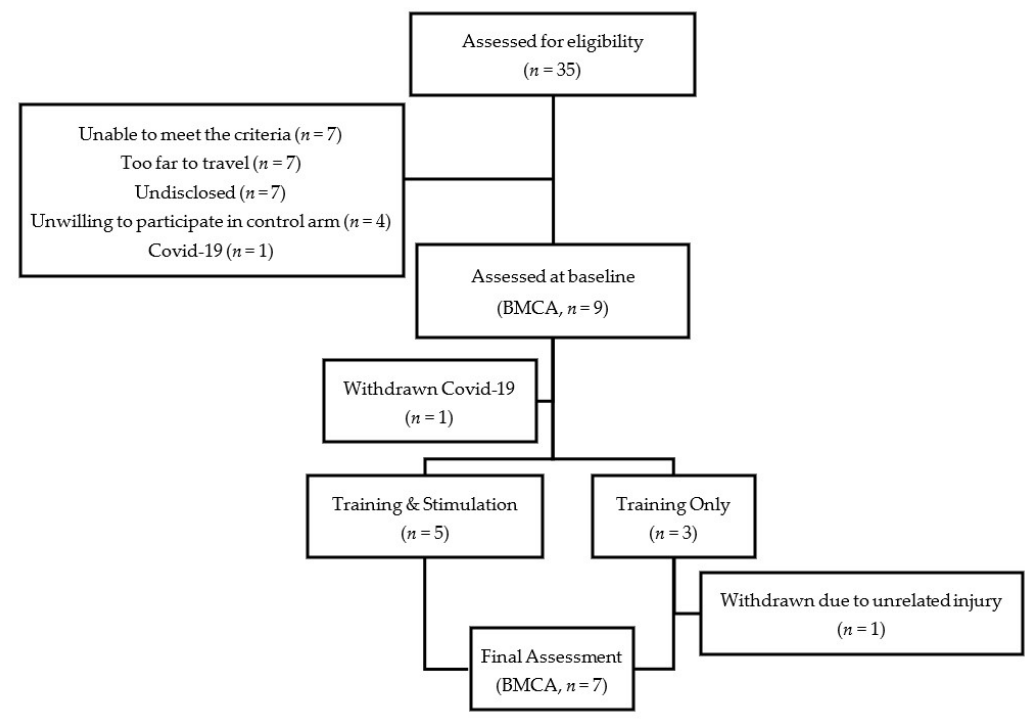
Figure 1. CONSORT flow diagram.